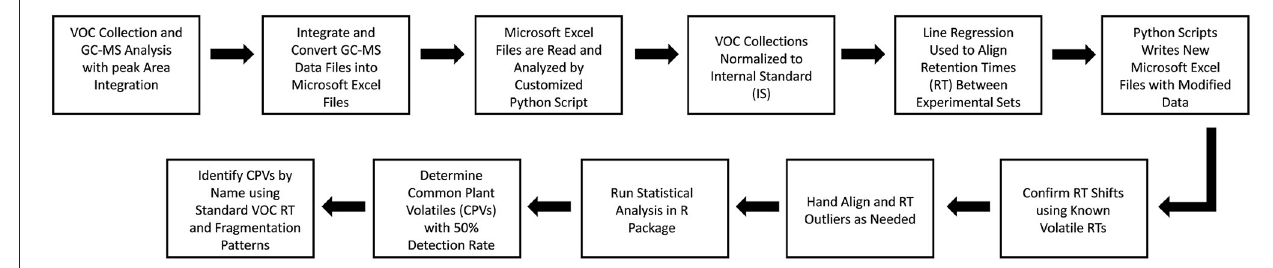
FIGURE 2 | Experimental data processing and analysis pathway for the VOC peak alignment with linear regression approach.